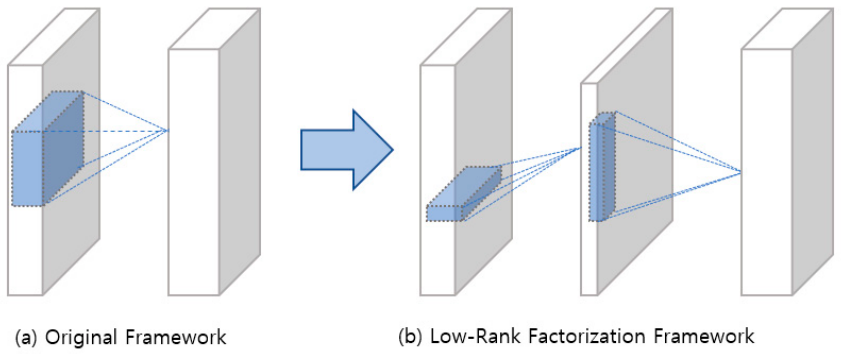
Figure 1. Overall framework of original and the low-rank constraint convolutional layers.